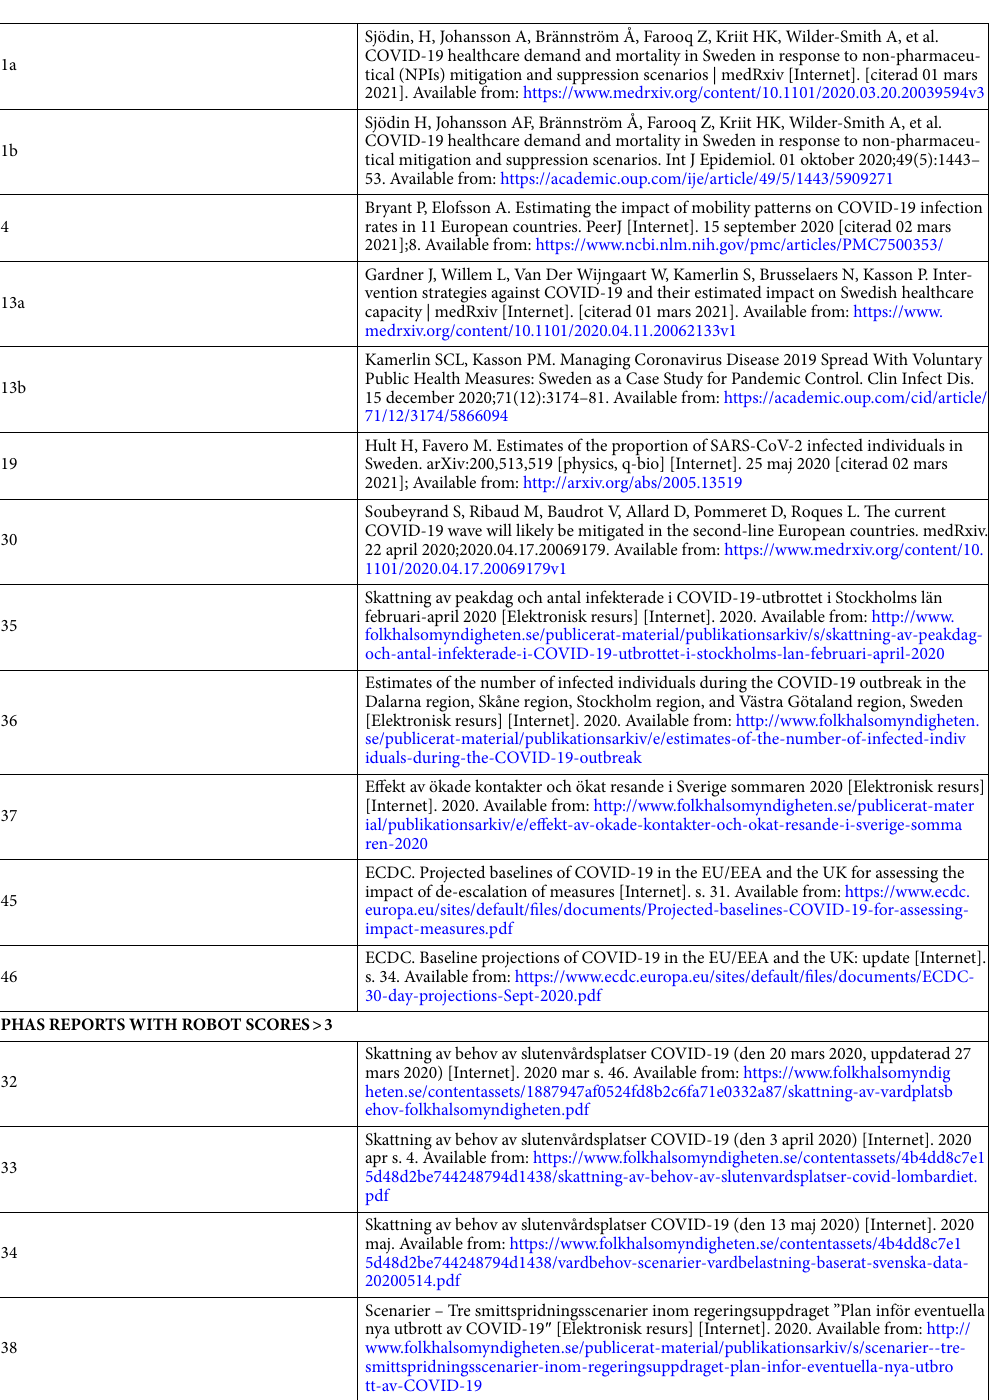
Table 1. Studies that passed the assessment of systematic bias (ROBOT evaluation) and additional PHAS reports (references 32,33,34 and 38 added at the end of the listing) considered in the data synthesis and secondary validation